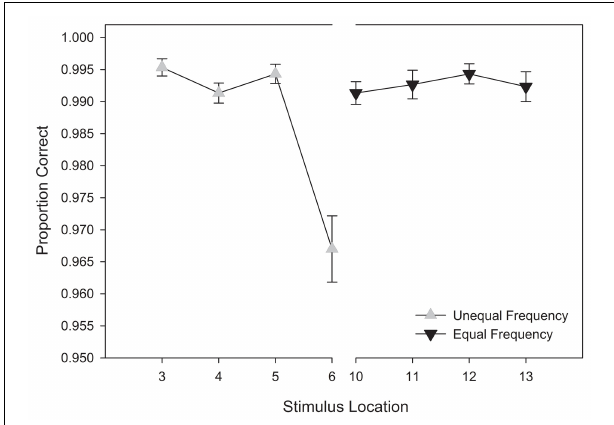
FIGURE 11 | Training categorization response time in the unequal frequency, unequal distribution condition. Stimulus values correspond to stimuli selected from the training range (i.e., stimuli 3–13). Error bars represent 1 standard error of the mean ( N =